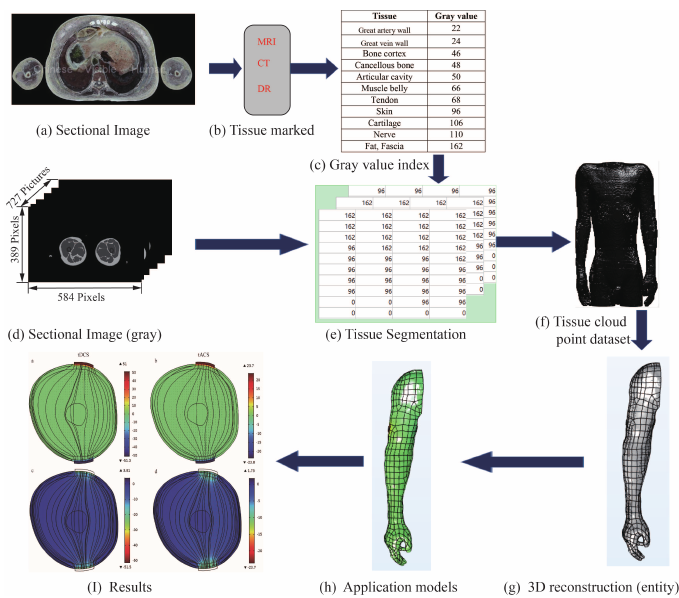
Figure A1. Chinese digital arm production